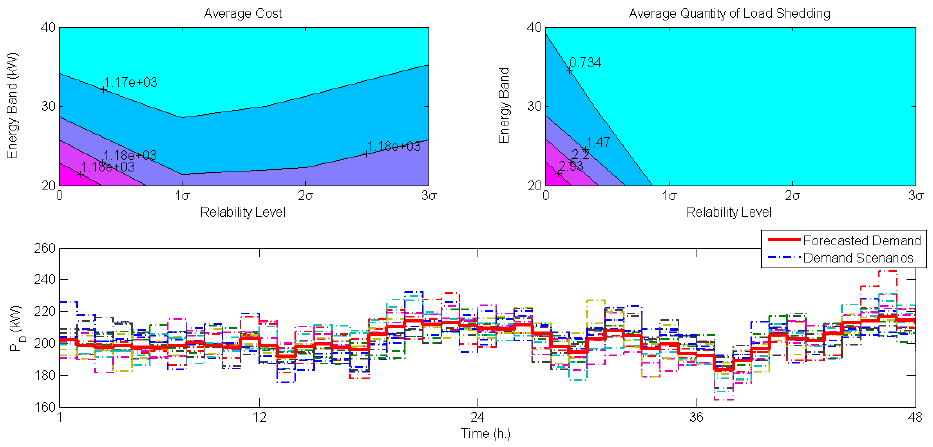
Figure 7. Average operational